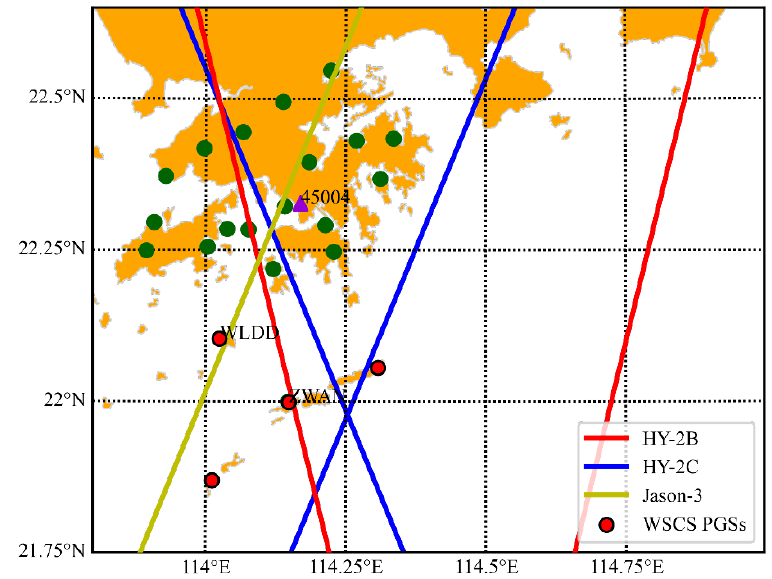
Figure 3. Sketch of WSCS and the related satellite altimeters orbits. The red dots represent the permanent GNSS stations of WSCS which were placed on the Zhiwan, Wailingding, Miaowan, and Dangan islands. There is also a PGS installed in Hong Kong (HKWS) from GRC. A total of 19 CORS stations of HKGSS (dark green points) were processed together with the WSCS data to validate the ZWD of the